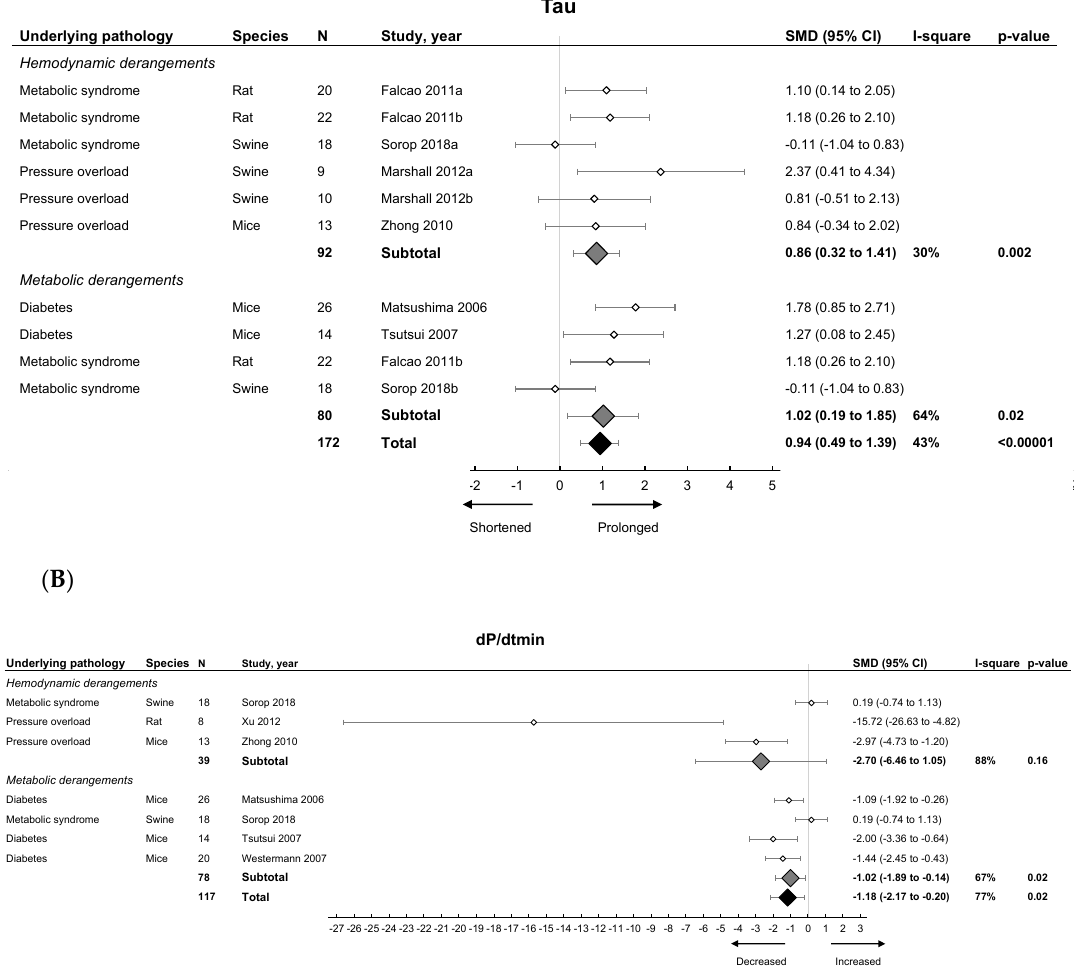
Figure 3. The effect of LVDD/HFpEF on cardiac parameters Tau (panel ( A )) and dP/dt min (panel ( B )). Forrest plot; the right side shows an increased effect in LVDD/HFpEF animals, the left side shows a decreased effect in LVDD/HFpEF animals. Data are presented as SMDs with 95% CI. Arrows indicate shortened and prolonged time constant of relaxation Tau ( A ), and decreased and increased rate of pressure change dP/dt min ( B ) respectively. Only the first author of each study is shown; multiple comparisons within one study are shown with a, b, c or d and correspond with the study overview (Table S1). CI, confidence interval; I 2 , measurement of heterogeneity; N, cumulative sample size; SMD, standardized mean difference; dP/dt min , minimum rate of pressure change; Tau, time constant of ventricular relaxation.